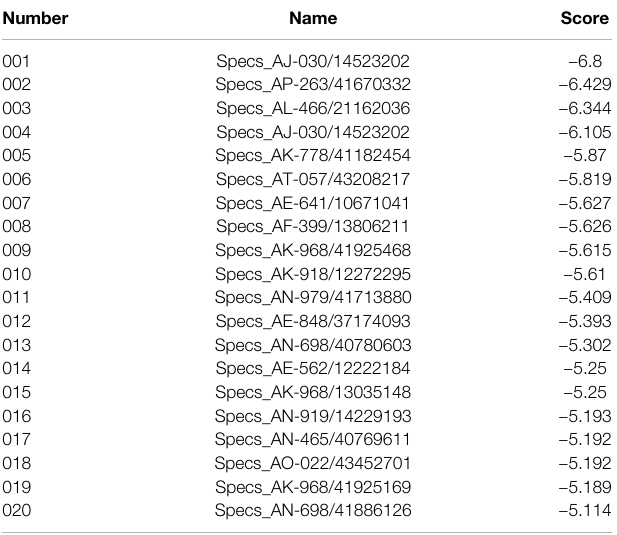
TABLE 1 | Sequence of the top 20 small molecules with highest docking scores.